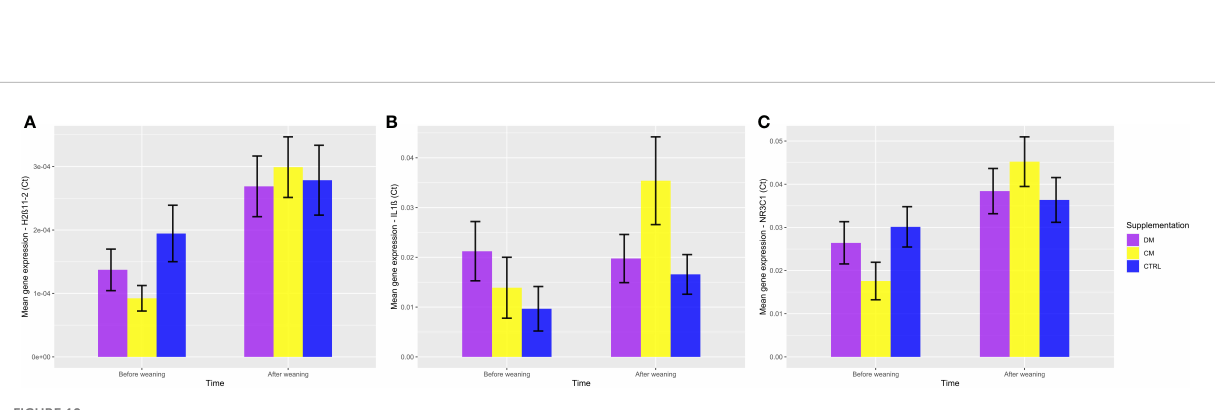
FIGURE 10 Representation of the gene expression of the three evaluated genes, (A) HSD11 b 2, (B) IL-1 b , and (C) NR3C1, considering 2 ΔΔ Ct values, divided by supplementation group and weaning event. DM (Asinine milk), CM (Cow skimmed milk), and CTRL (Control without supplementation). Data represent averages ± standard error of the mean